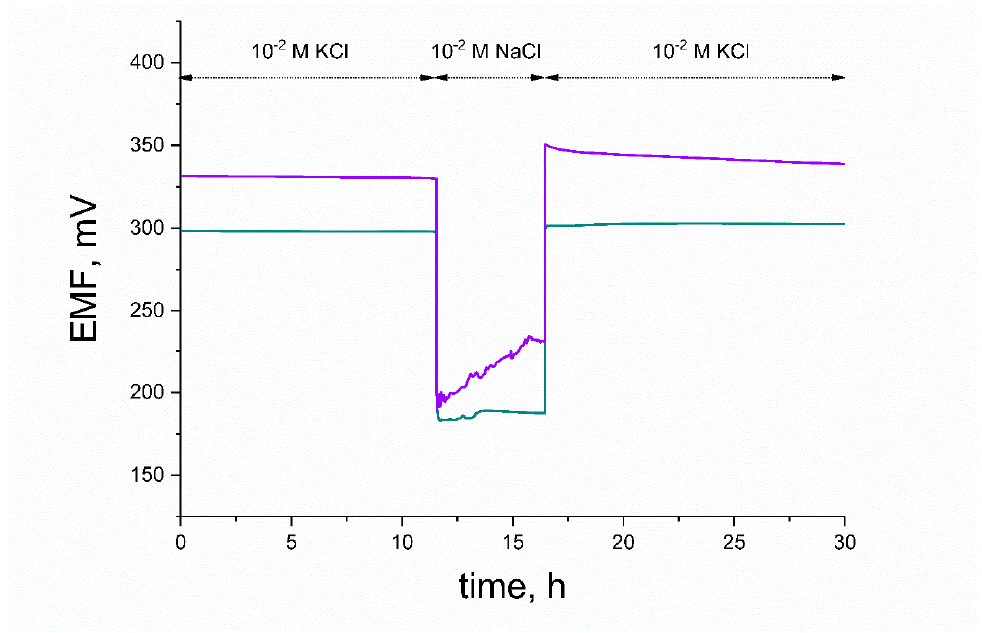
Figure 13. Water layer test of GCD/RuO 2 •xH 2 O/K + -ISM (blue curve) and GCD/RuO 2 /K + -ISM (violet curve) electrode.